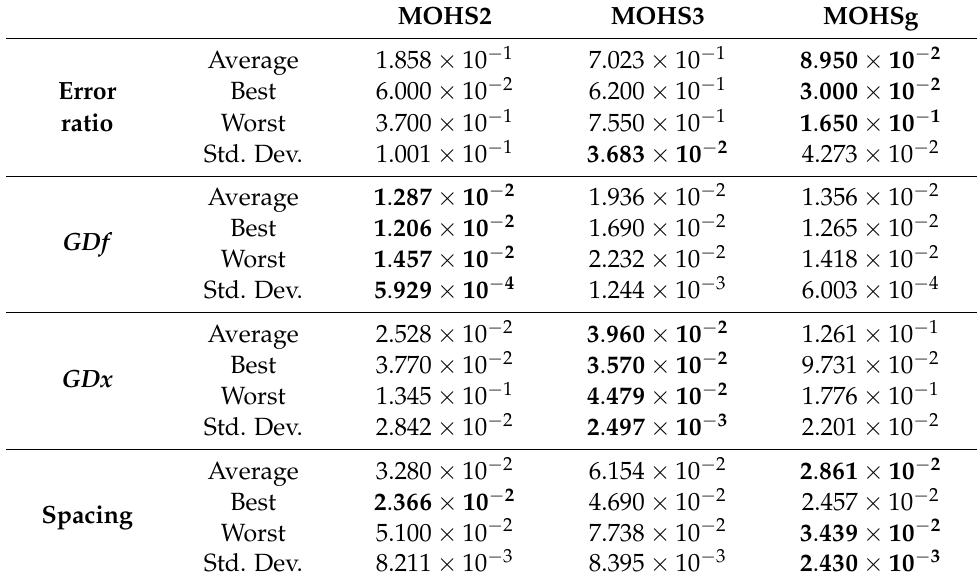
Table 7. Statistical analysis for problem